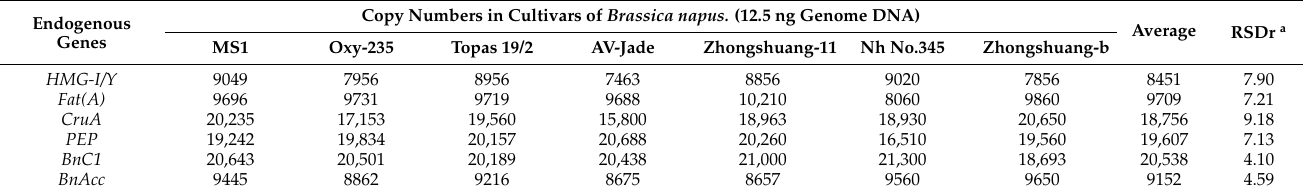
Table 3. Copy number variation of reference targets among seven Brassica napus cultivars. Copy Numbers in Cultivars of Brassica napus. (12.5 ng Genome